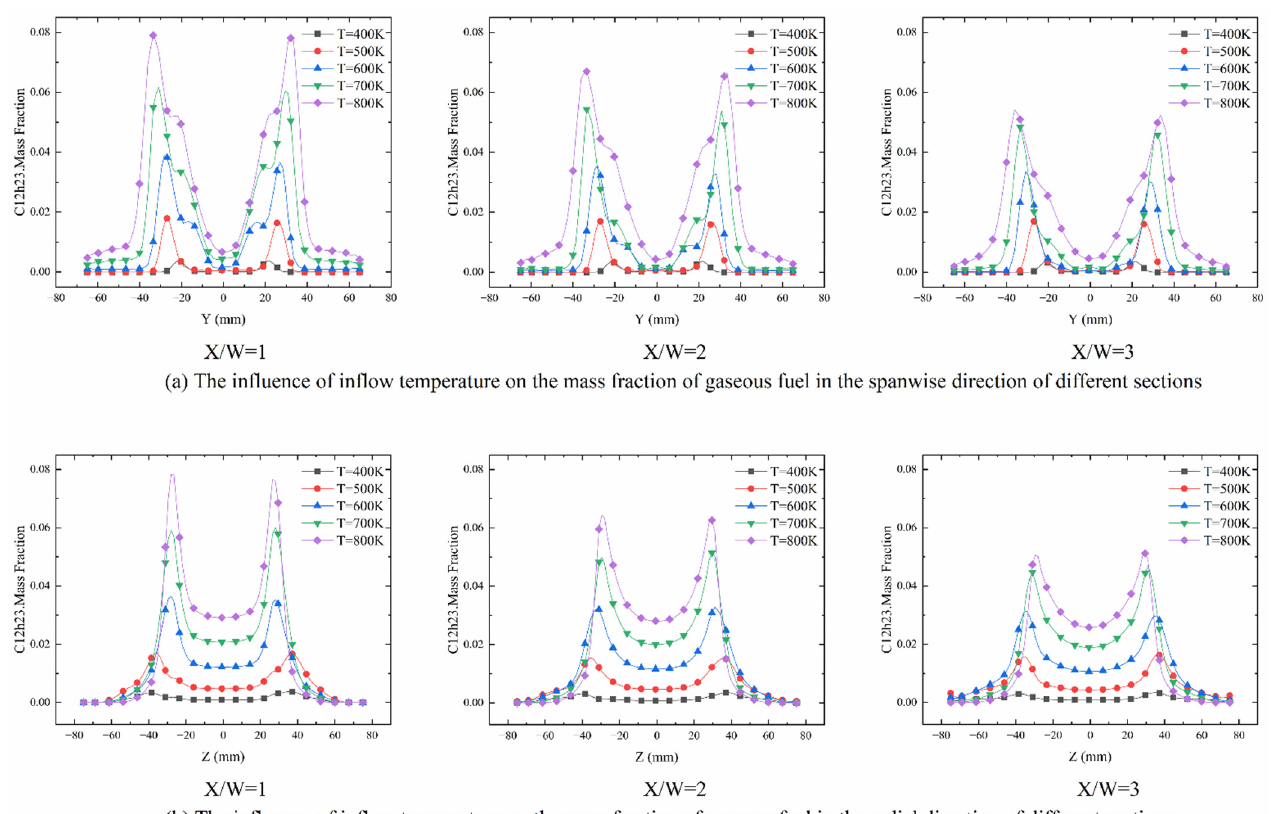
Figure 12. The influence of inflow temperature on the mass fraction of gaseous fuel of different sections.